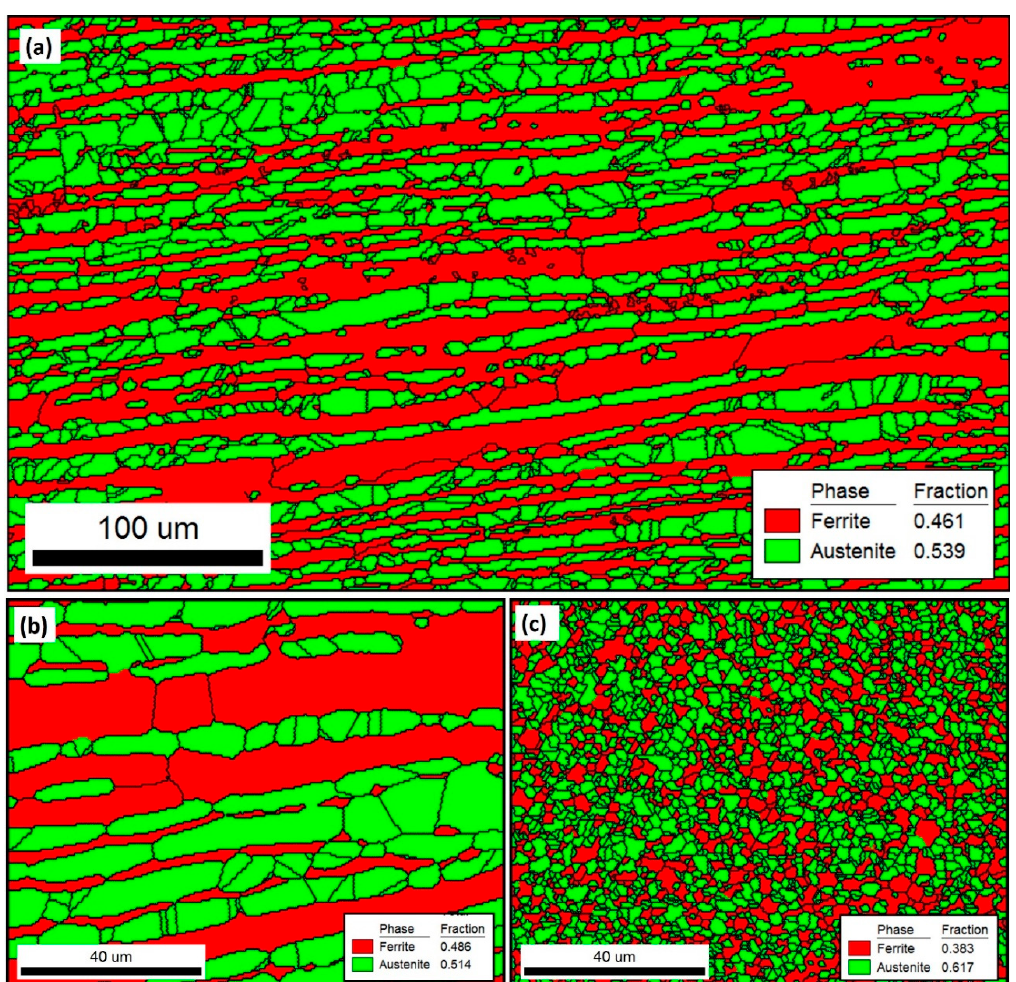
Figure 13. Phase-colored maps (austenite in green and ferrite in red) for the base material ( a , b ) and the FSWed joint stir zone ( c ) with the high angle boundaries (HABs) >15 o in black lines superimposed. The data in ( a ) is obtained using a 1 µ m step size while the data in ( b , c ) are obtained using a 0.5 µ m step size.